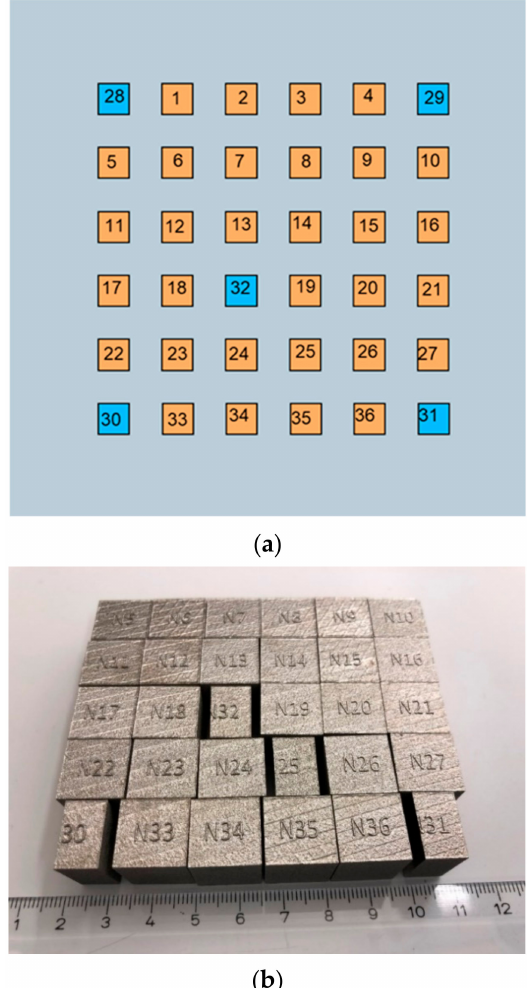
Figure 1. ( a ) Illustration of cube locations with the orange color representing experiments with di ff erent process parameter sets and blue color representing repeated experiments (replicates); ( b ) Some of the manufactured